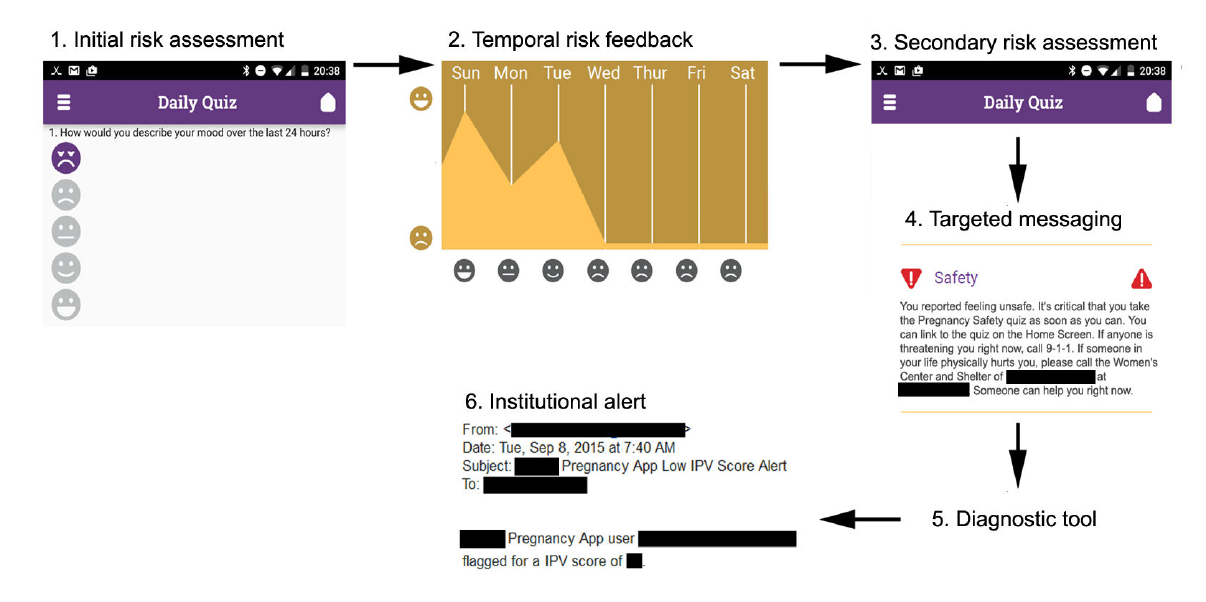
Figure 2. Logic diagram to identify, communicate, and intervene with a specific preterm birth risk (eg, intimate partner violence). From left: (1) user completes daily questionnaire, (2) user receives feedback on risk factor over time, (3) algorithm determines whether additional diagnostic questions are necessary, (4) user receives targeted messaging, (5) user completes validated diagnostic tool, and (6) physician receives real-time alert of intimate partner